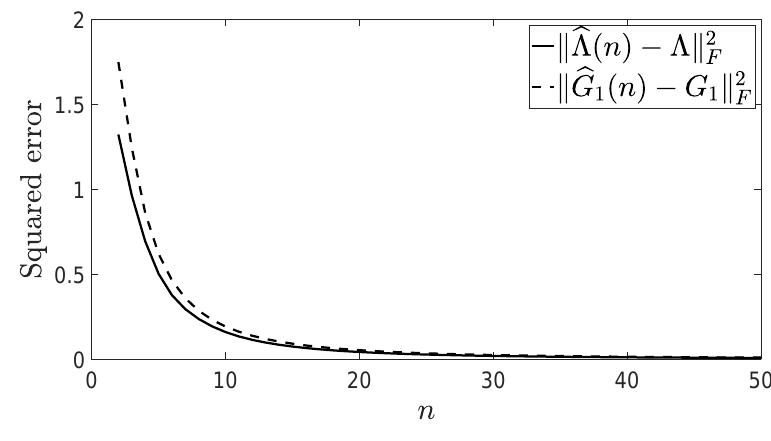
Figure 2. Squared error made when Λ and G 1 are estimated by (cid:98) Λ ( n ) and (cid:98) G 1 ( n ) ,